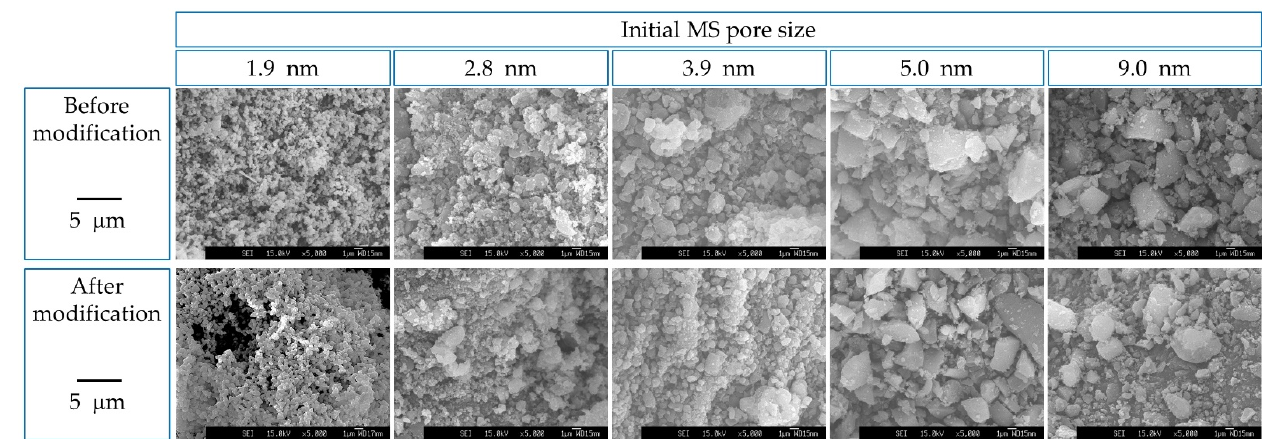
Figure 1. SEM image of MS before and after surface modification.